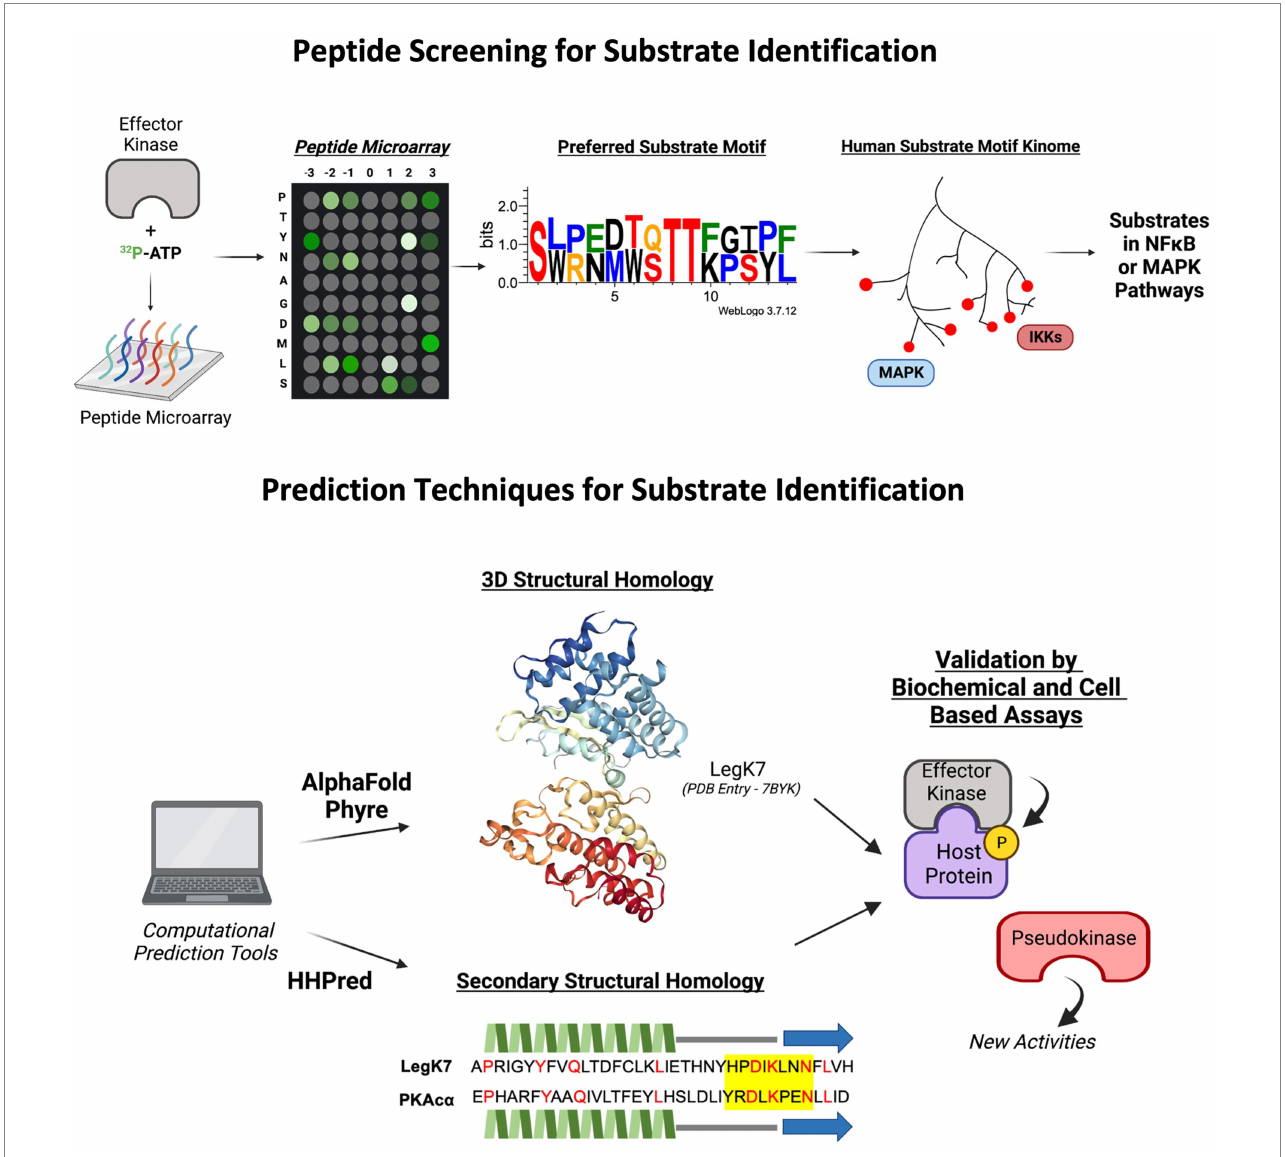
FIGURE 3 Novel predictive tools and applications, such as peptide screens and computational structure and folding algorithms in identifying putative effector kinases and their host substrates. LegK7 crystal structure from Protein Database (PDB Entry Number: 7BYK). Protein motif sequence generated through WebLogo3. The predicted secondary structure alignment of PKAc ɑ and LegK7 is shown. Beta strands are represented by blue arrows, helices are represented by green jagged lines, loops are represented as straight gray lines, catalytic motif is highlight yellow, and identical residues are indicated by red